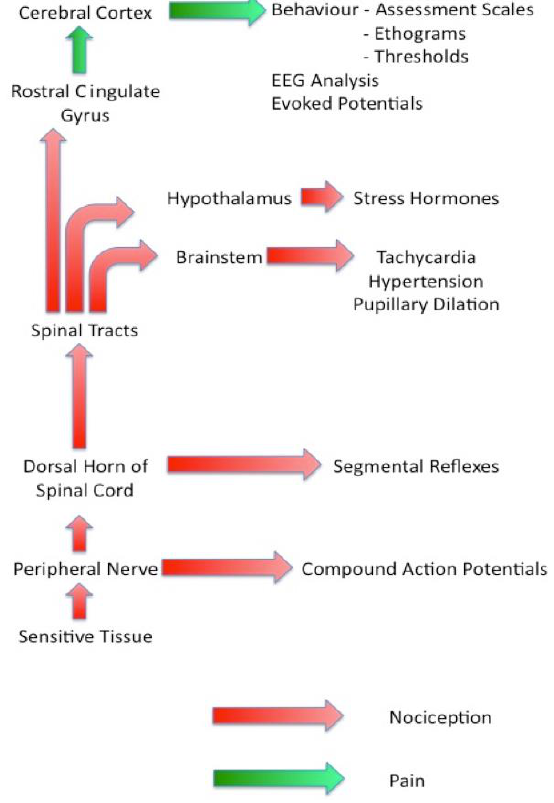
Figure 1. Diagrammatic representation of the sensory nociceptive pathways. EEG: Figure 1 . Diagrammatic representation of the sensory nociceptive pathways. EEG: electrocardiograma.